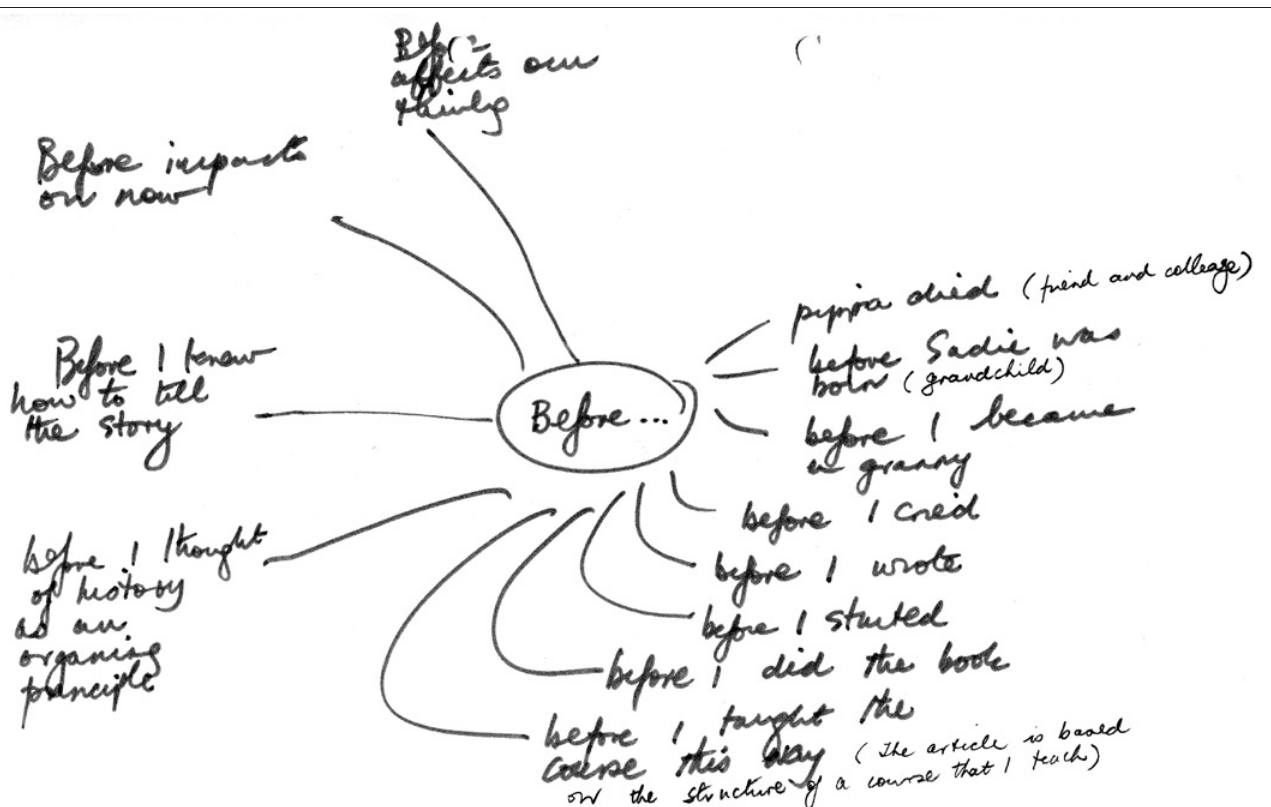
FIGURE 1: The Free writing I produced in response to the stimulus, which was the word